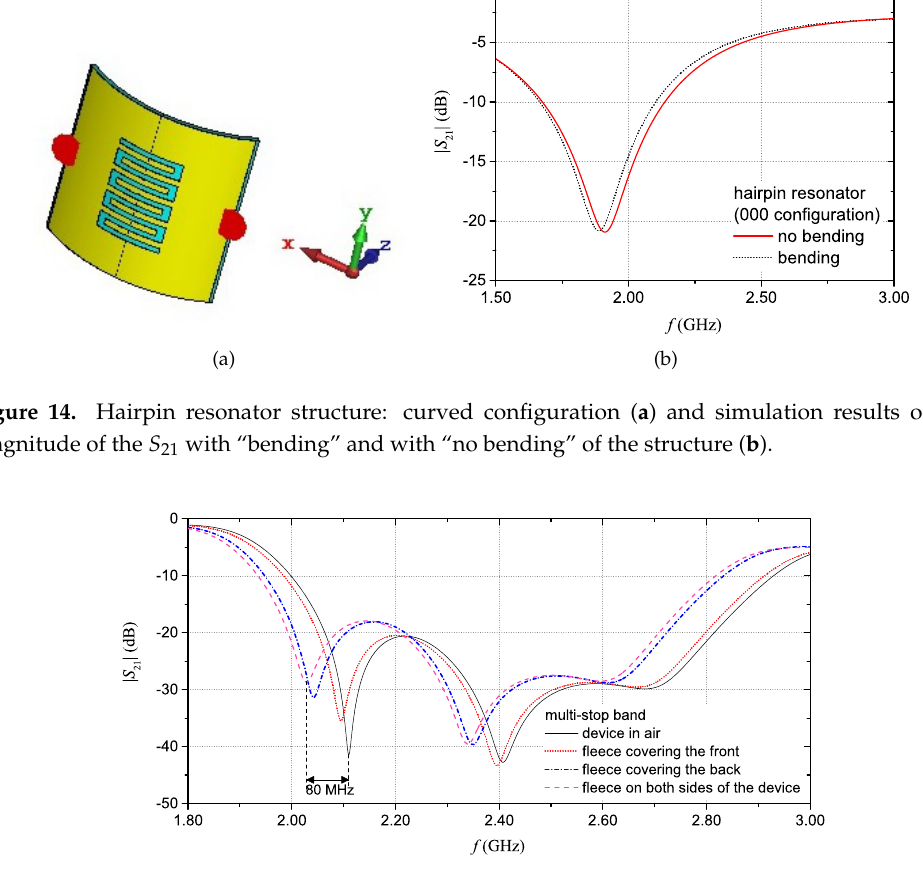
Figure 15. Multi-stopband device: | S 21 | simulation results when a 5 mm-thick layer of fleece covers the front of the device; the back of the device; and both sides of the device. Results are compared with the | S | of the device in air (i.e.,with no additional 21